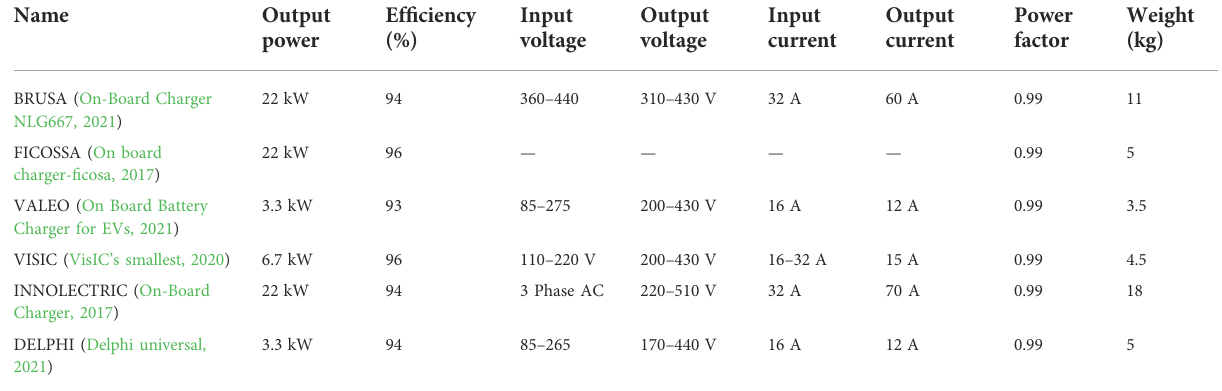
TABLE 8 Commercial on-board charger